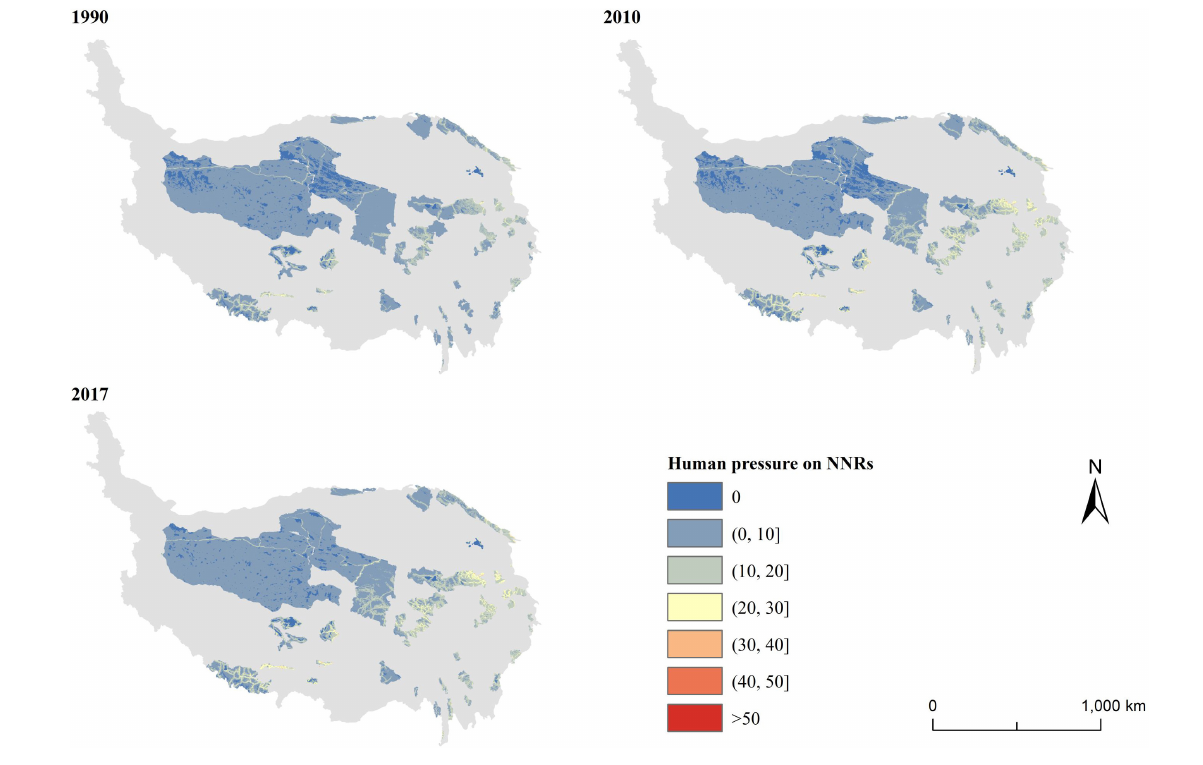
FIGURE 3 | Spatiotemporal pattern of human pressure in NNRs during 1990–2017.